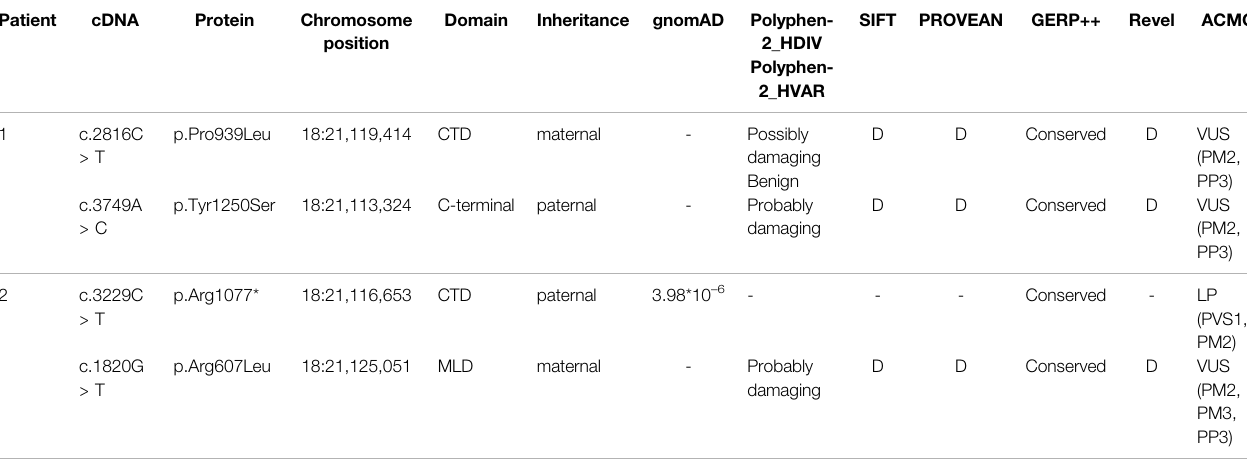
TABLE 2 | Summary of NPC1 variants reported in this